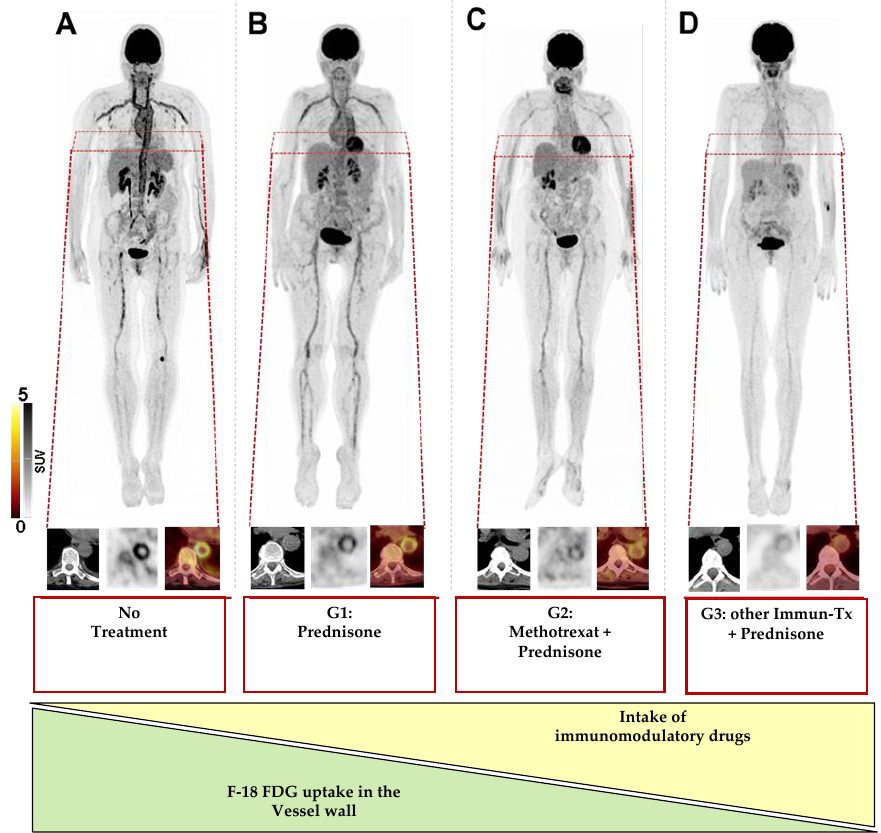
Figure 3. Maximum-intensity projections and magnified descending aorta in patients with ( A ) no treatment, ( B ) receiving prednisone alone (Group 1), ( C ) methotrexate in combination with prednisone (Group 2), or ( D ) prednisone in combination with other immunomodulatory drugs (Immuno-Tx, including mycophenolate mofetil, azathioprine, rituximab, and leflunomide) at the time of PET/CT (Group 3). The uptake in vessel walls decreased with the additional intake of immunomodulatory drugs. For every case, computed tomography (CT), positron emission tomography (PET), and PET/CT are